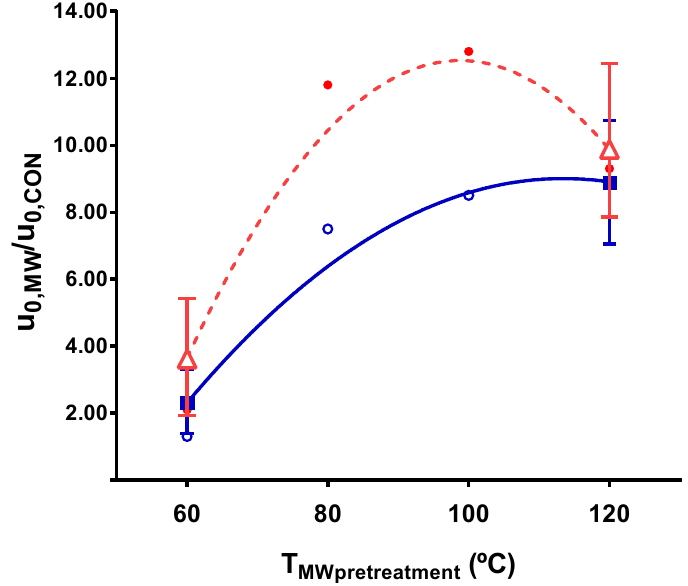
Figure 4. Pretreatment temperature influence on initial extraction rate respect to the control for a solid–liquid ratio of 0.30 g/mL ( ■ polyphenol extraction, Δ anthocyanin extraction, ○ and ● experimental points for polyphenols and anthocyanins, respectively).